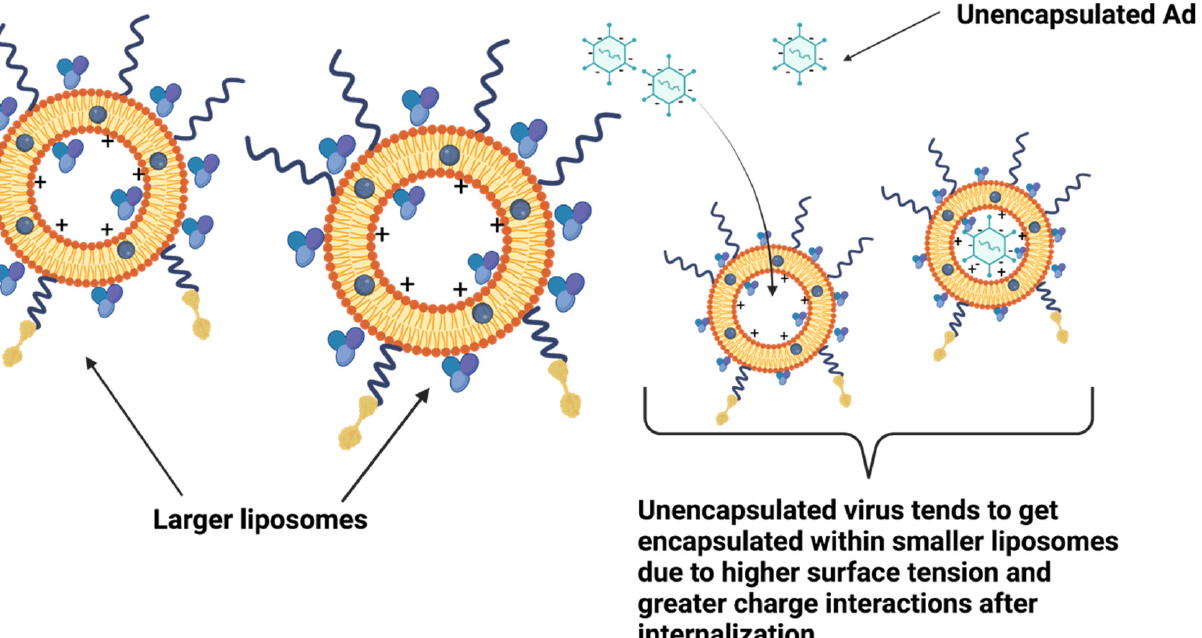
encapsulated within smaller liposomes due to higher surface tension and greater charge interactions